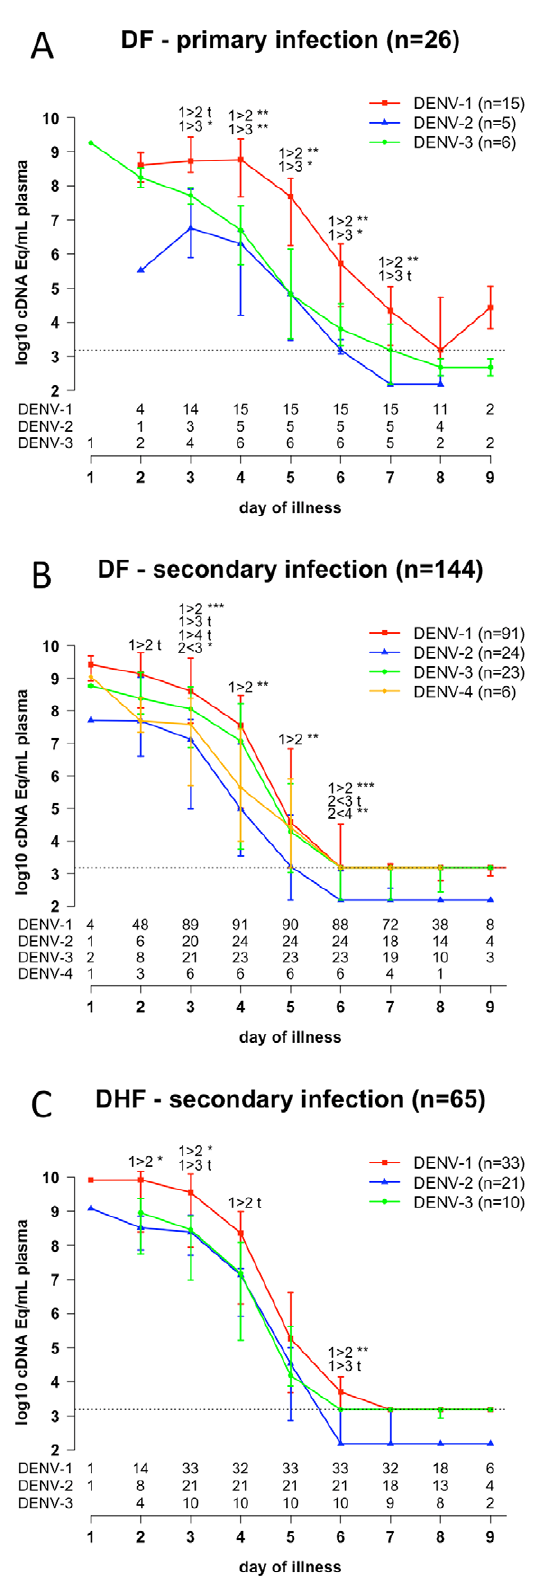
Figure 1. Magnitude of DENV viremia by illness day. Levels of DENV-1, -2, -3 and -4 genome equivalent cDNA copies per millilitre were determined in serial plasma samples from patients with A ) primary DF (n=26), B ) secondary DF (n=144) and C ) secondary DHF (n=64). Data